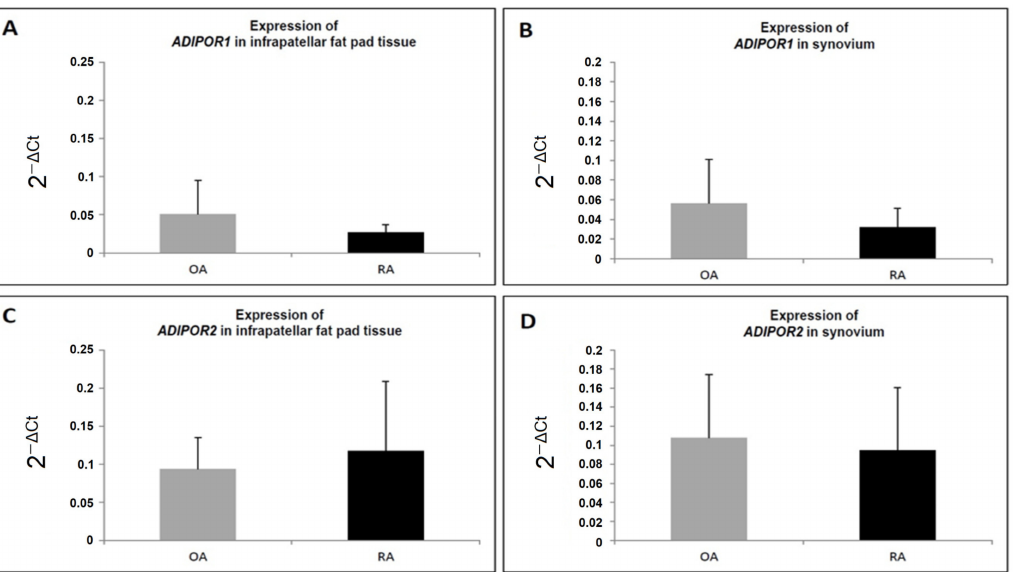
Figure 3. mRNA expression levels of adiponectin receptor 1 (ADIPOR1) and adiponectin